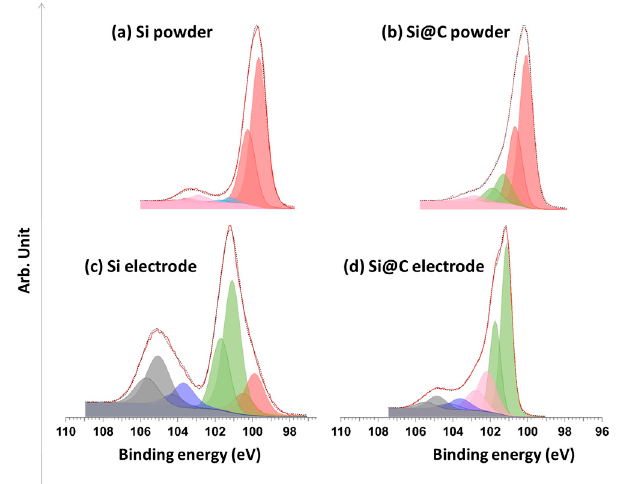
Figure 7. Si 2p XPS spectra for ( a ) pristine Si powder, for ( b ) pristine Si@C powder, for both materials embedded inside a composite electrode with ( c ) Si and for ( d ) Si@C.